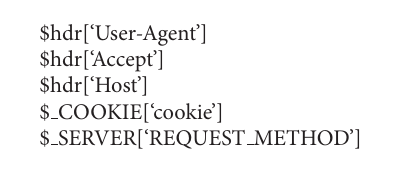
Algorithm 2: Request’s headers checked by the STBOA algorithm.